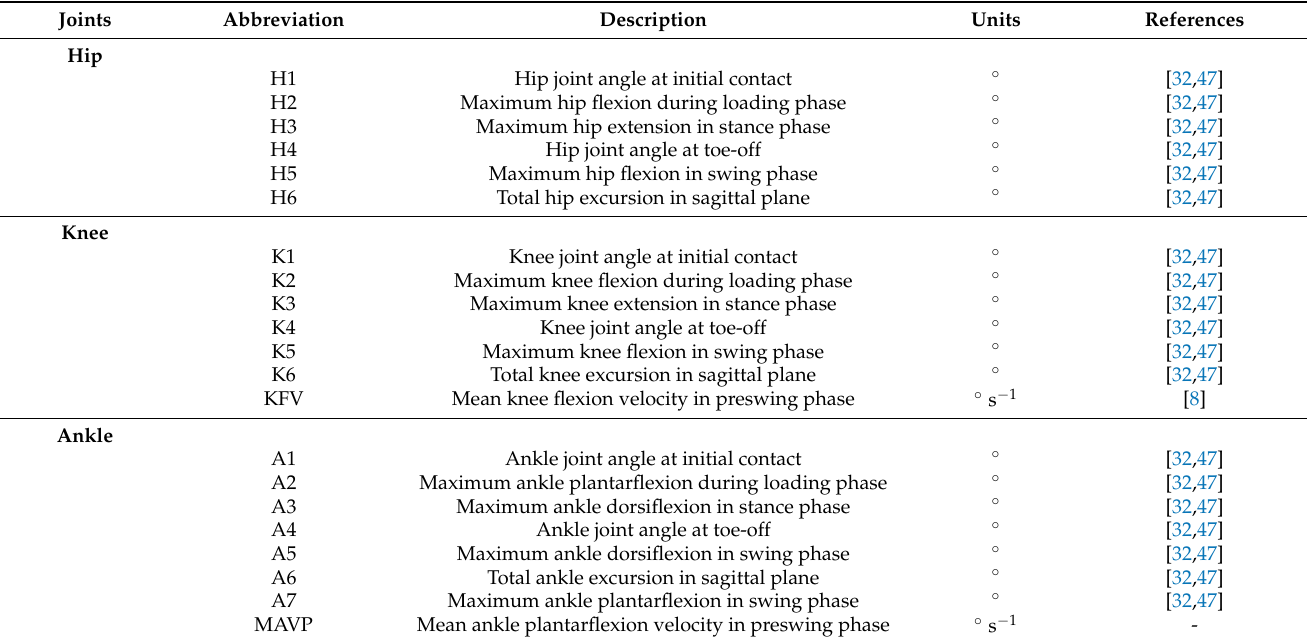
Table 2. Description of the kinematic parameters computed for the hip, knee, and ankle